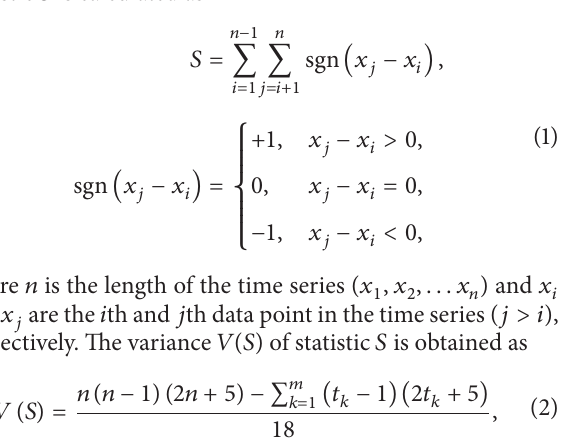
Figure 3: Spatial distribution of annual precipitation within the period 1960–2006 in Liaoning province,